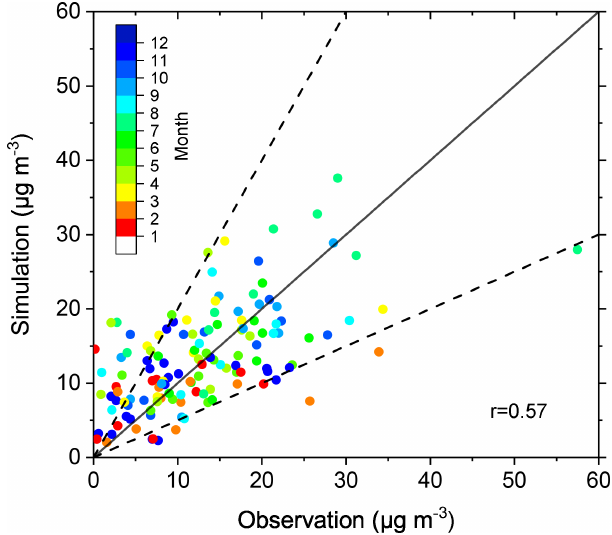
Figure 2. Comparison of modeled gaseous NH 3 concentrations with corresponding monthly measurements of NH 3 from Septem- ber 2015 to August 2016. The 1 : 2 and 2 : 1 dashed lines are shown for reference and the Pearson correlation coefficient ( r ) is shown